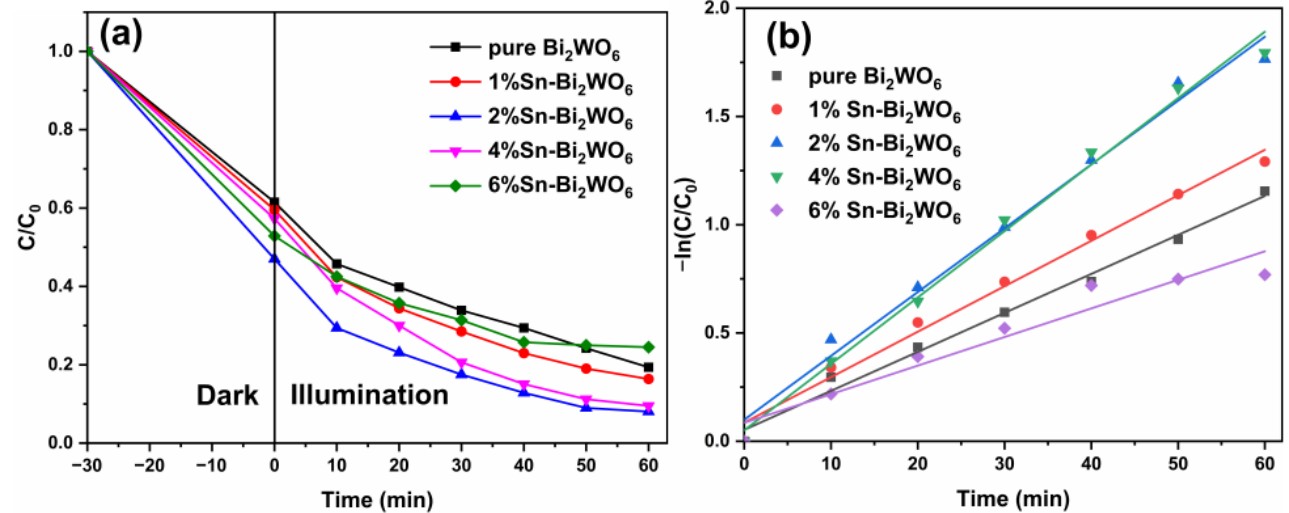
Figure 8. Photocatalytic degradation degree curves of MB ( a ) and kinetic fitting curves for pure Bi 2 WO 6 and Sn-Bi 2 WO 6 ( b ).